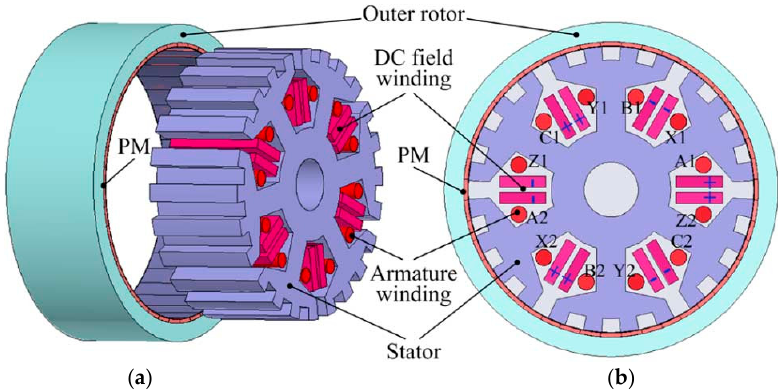
Figure 6. Hybrid-excited split-tooth SVPM machine: ( a ) 3D structure; ( b ) Cross-sectional view [20].